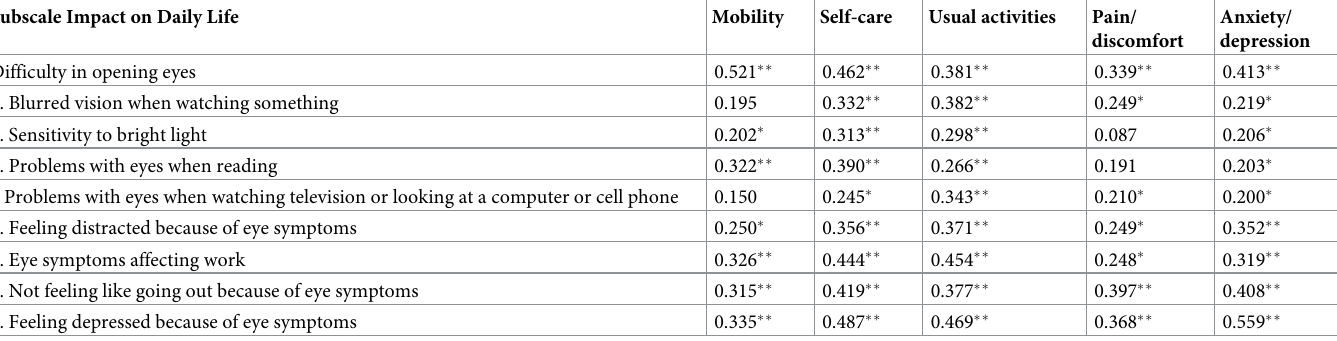
Table 6. Correlation matrix between the quality of life assessed by the subscale Impact of Daily Life scores and scores from EQ-5D-5L items among DED patients. Subscale Impact on Daily